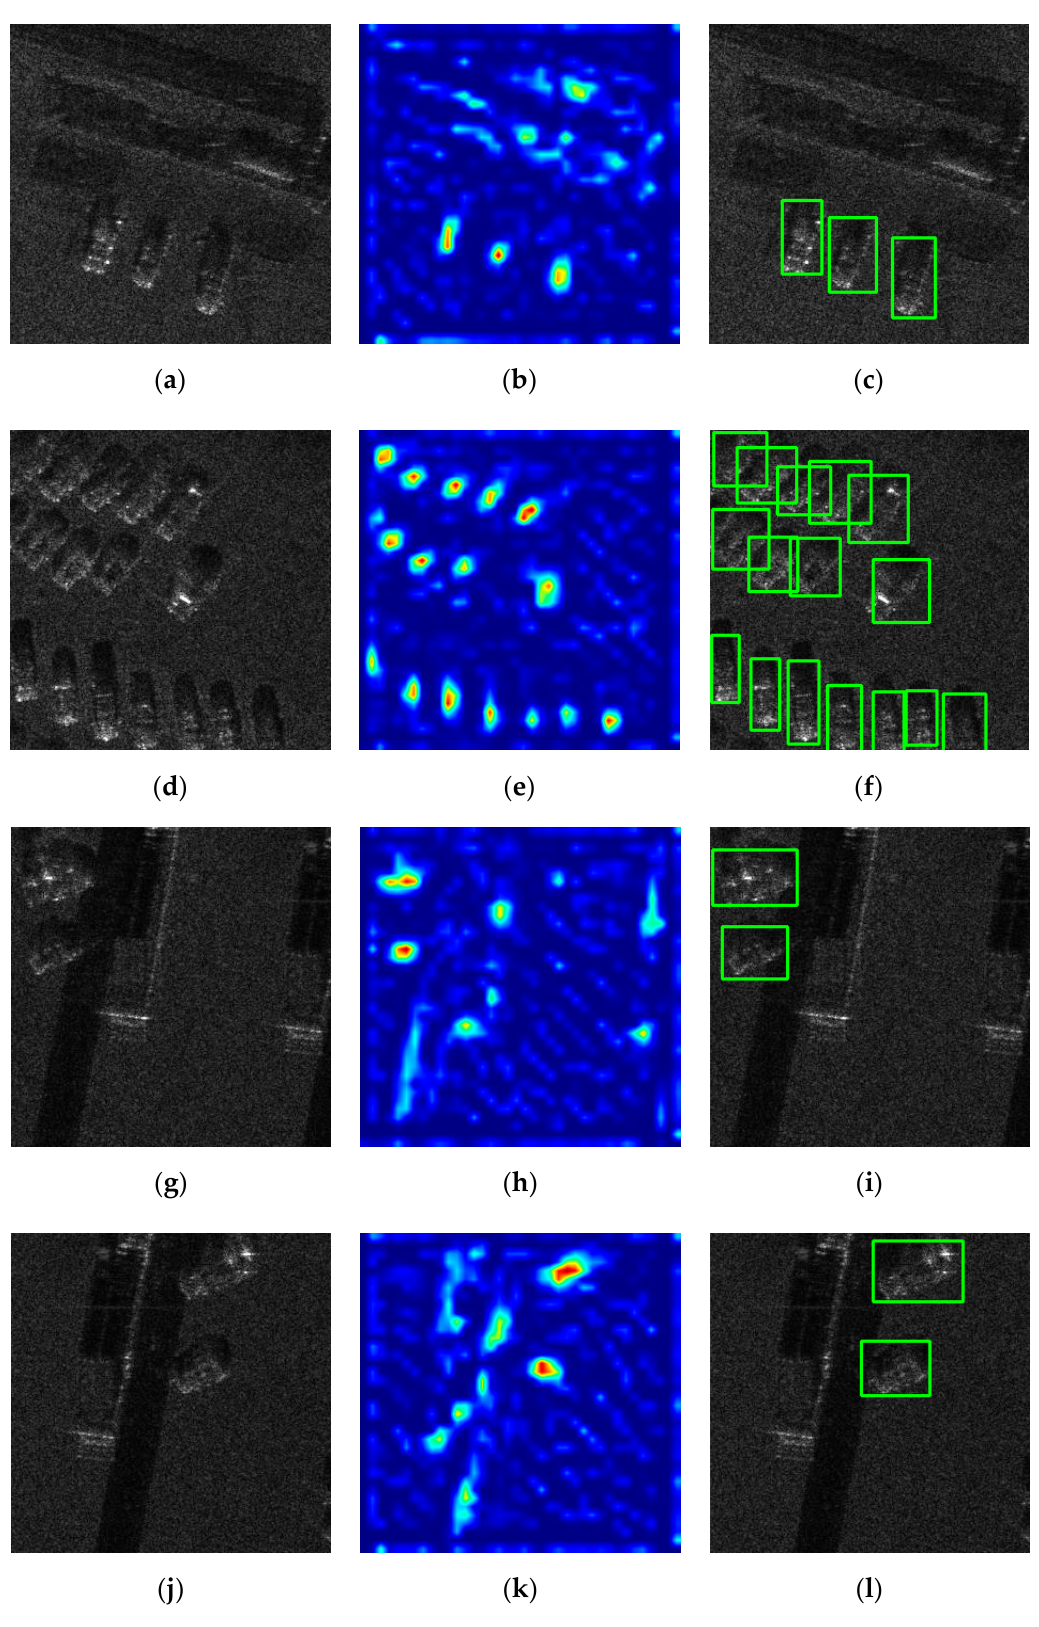
Figure 7. Original SAR sub-images and their corresponding attention maps and the detection results. ( a , d , g , j ) Original SAR sub-images. ( b , e , h , k ) Corresponding attention maps. ( c , f , i , l ) Corresponding detection results.